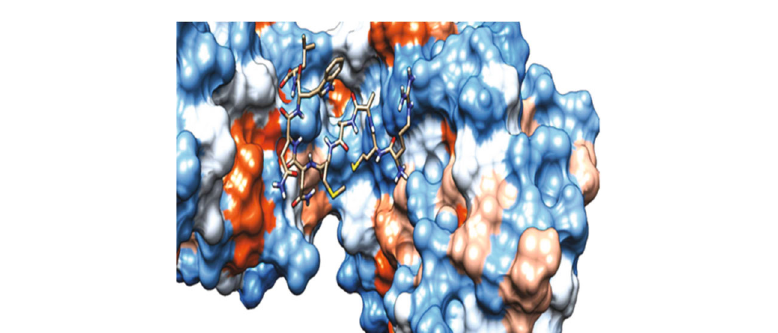
Figure 16: Illustration of the 2D interaction of the best docking poses of RMAAMNQWL in the binding sites of HLA-A ∗ 02:06.